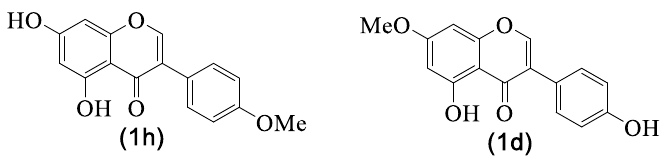
Figure 3. Biochanin A 1h and prunetin 1d structures.